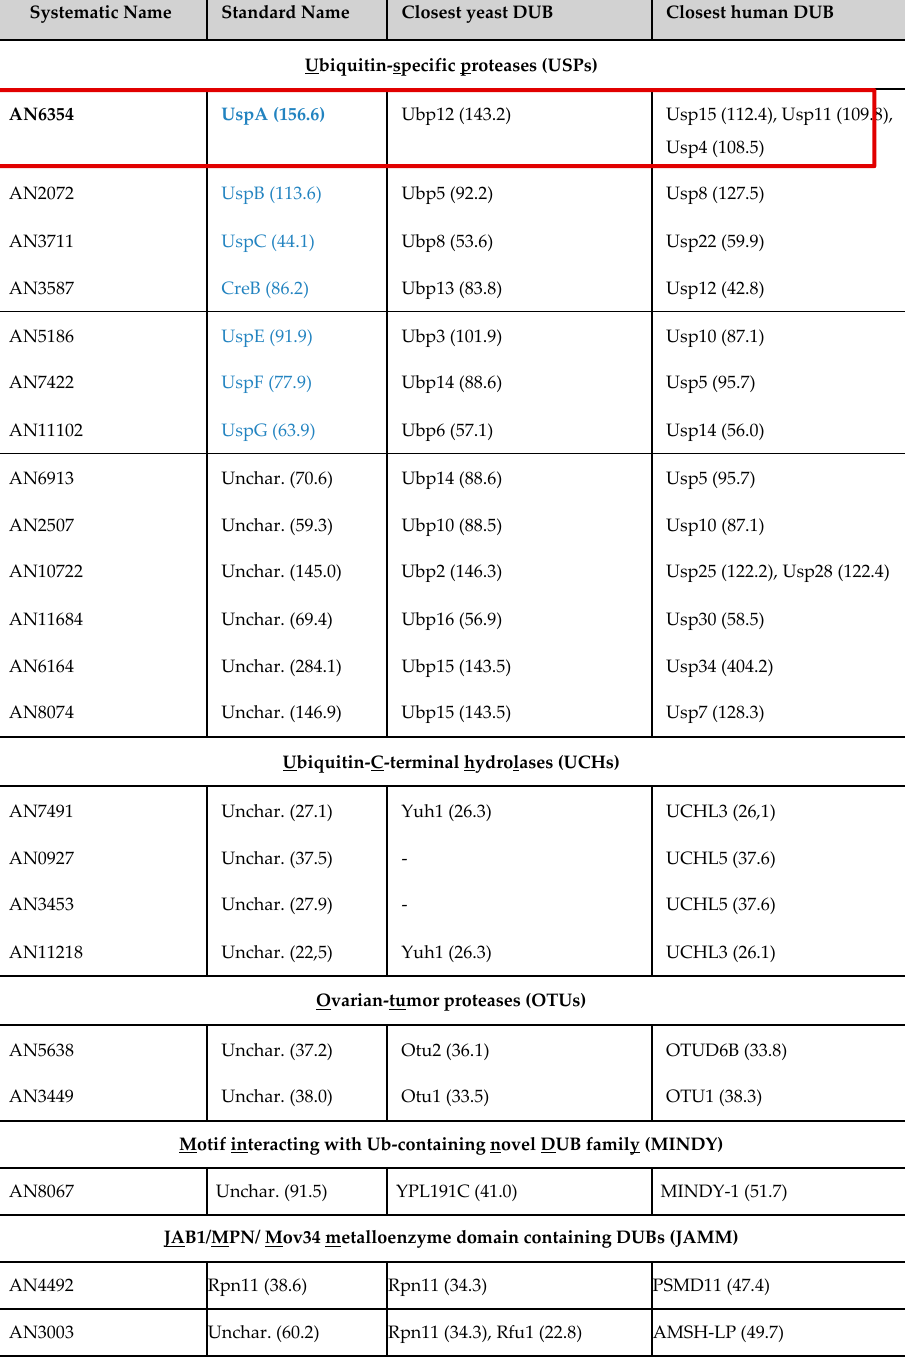
Table 1. The repertoire of deubiquitinating enzymes in A. nidulans . Biomolecules 2019 , 9 ,